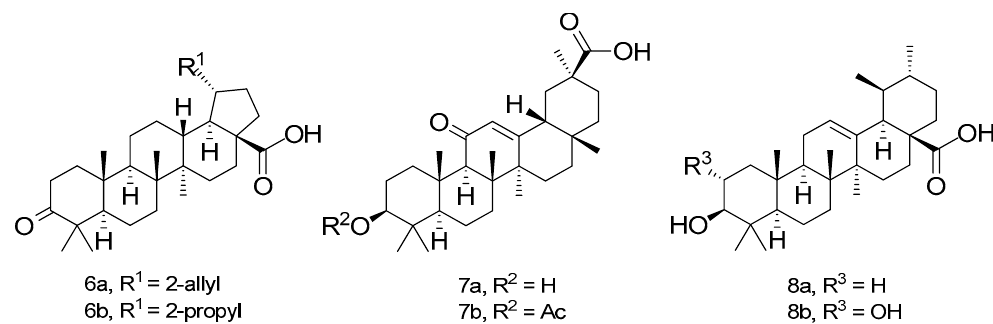
Figure 2. Triterpene acids, scaffolds for creating new compounds.